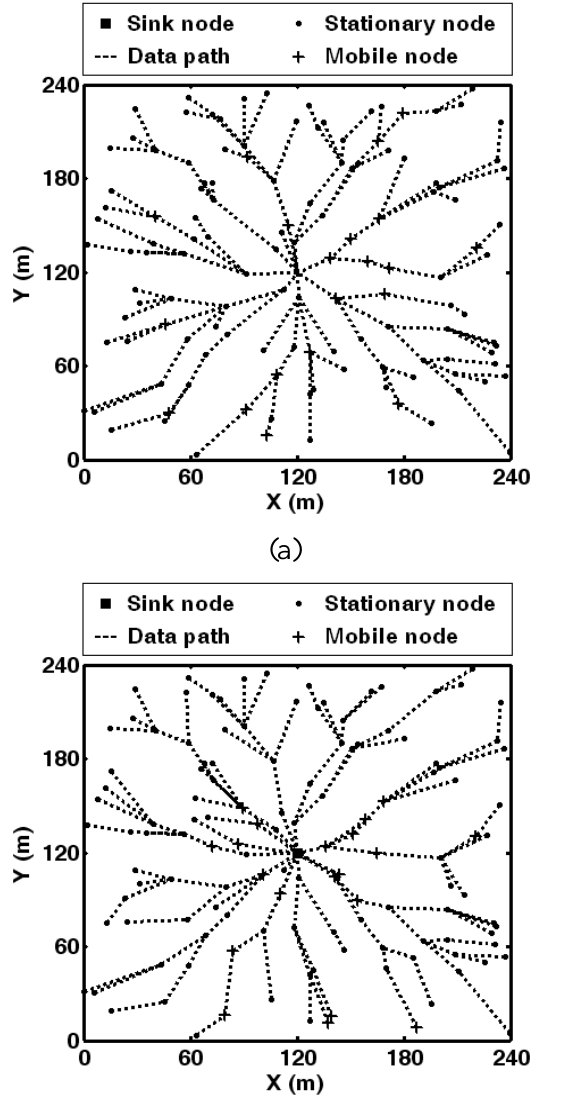
Figure 7. Optimized WSN deployment and communication paths adopting two algorithms: (a) PSO; (b)